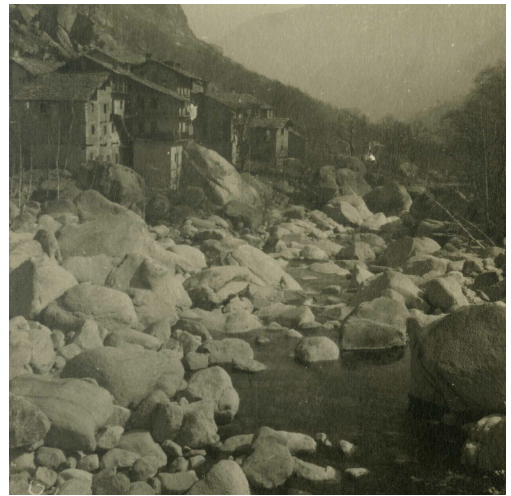
Figure 3. A village in the high Orco basin: very coarse deposits in the main channel as depicted in an old photograph (year